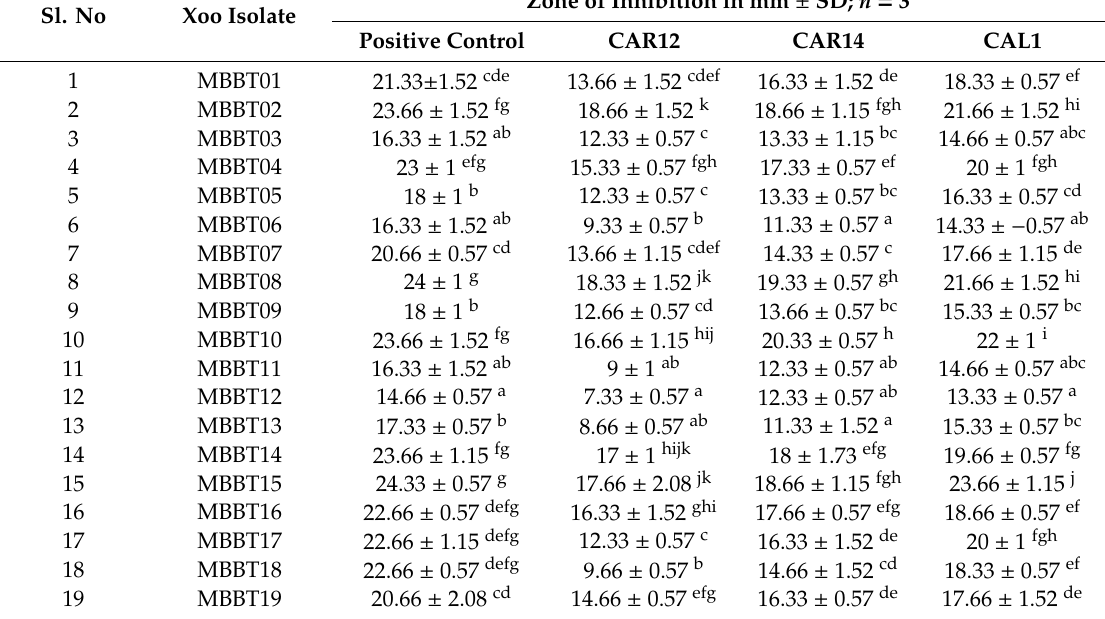
Table 5. Antimicrobial activity of fungal siderophores on Xanthomonas oryzae pv . oryzae (Xoo) from infected rice